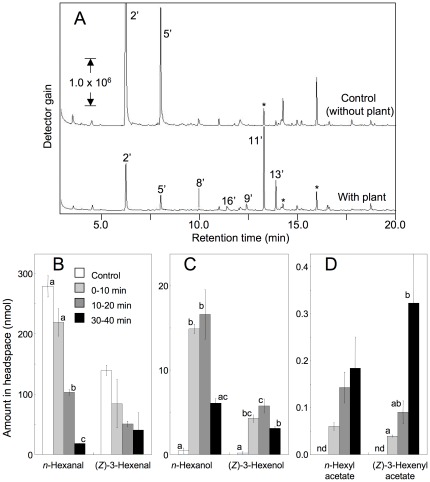
Conversion of U-13C-n-hexanal and U-13C-(Z)-3-hexenal over time by intact Arabidopsis plants.An intact Arabidopsis (Col-0) plant or a pot with soil (control) was placed in a plastic box with a cotton swab containing 2 µl of a mixture containing U-13C-n-hexanal and (Z)-3-hexenal. At 0, 10, or 30 min after the onset of exposure, an SPME fiber was positioned in the headspace of the box and volatiles were collected for 10 min. A: Typical chromatograms obtained after 40 min exposure. Compound numbers are as in the Fig. 2 legend. Numbers with prime marks indicate the corresponding 13C-labeled compound (>95% enrichment). The amounts of volatile aldehydes (B), volatile alcohols (C), and volatile acetates (D) were quantified from calibration curves constructed with authentic compounds. Error bars represent SE (n = 3). Data were analyzed by Tukey's test. Different letters above the bars indicate significant differences among the sampling times for each compound (P<0.05). nd: not detected.